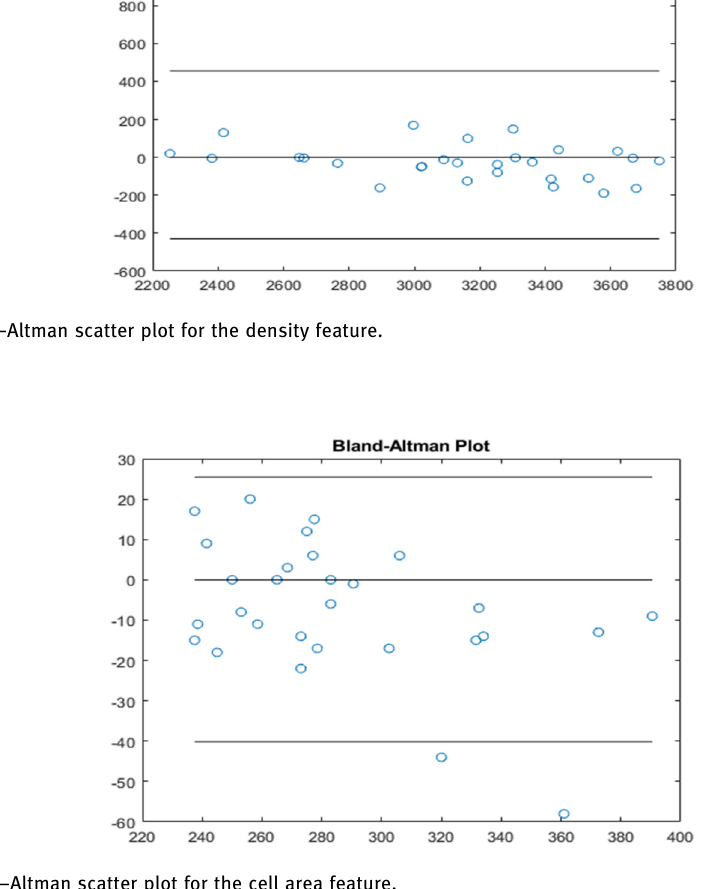
Figure 22: Bland – Altman scatter plot for the cell area